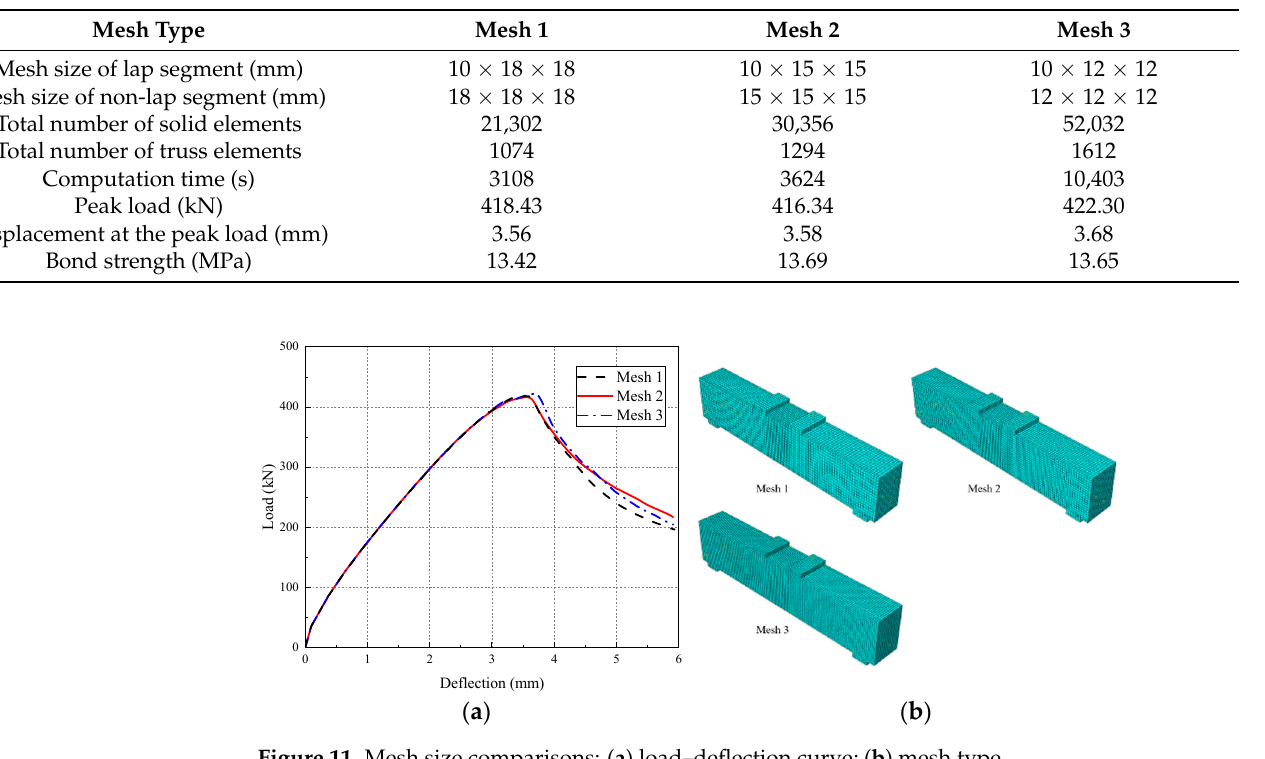
Figure 11. Mesh size comparisons: ( a ) load–deflection curve; ( b ) mesh type. Table 5. Mesh size analysis.